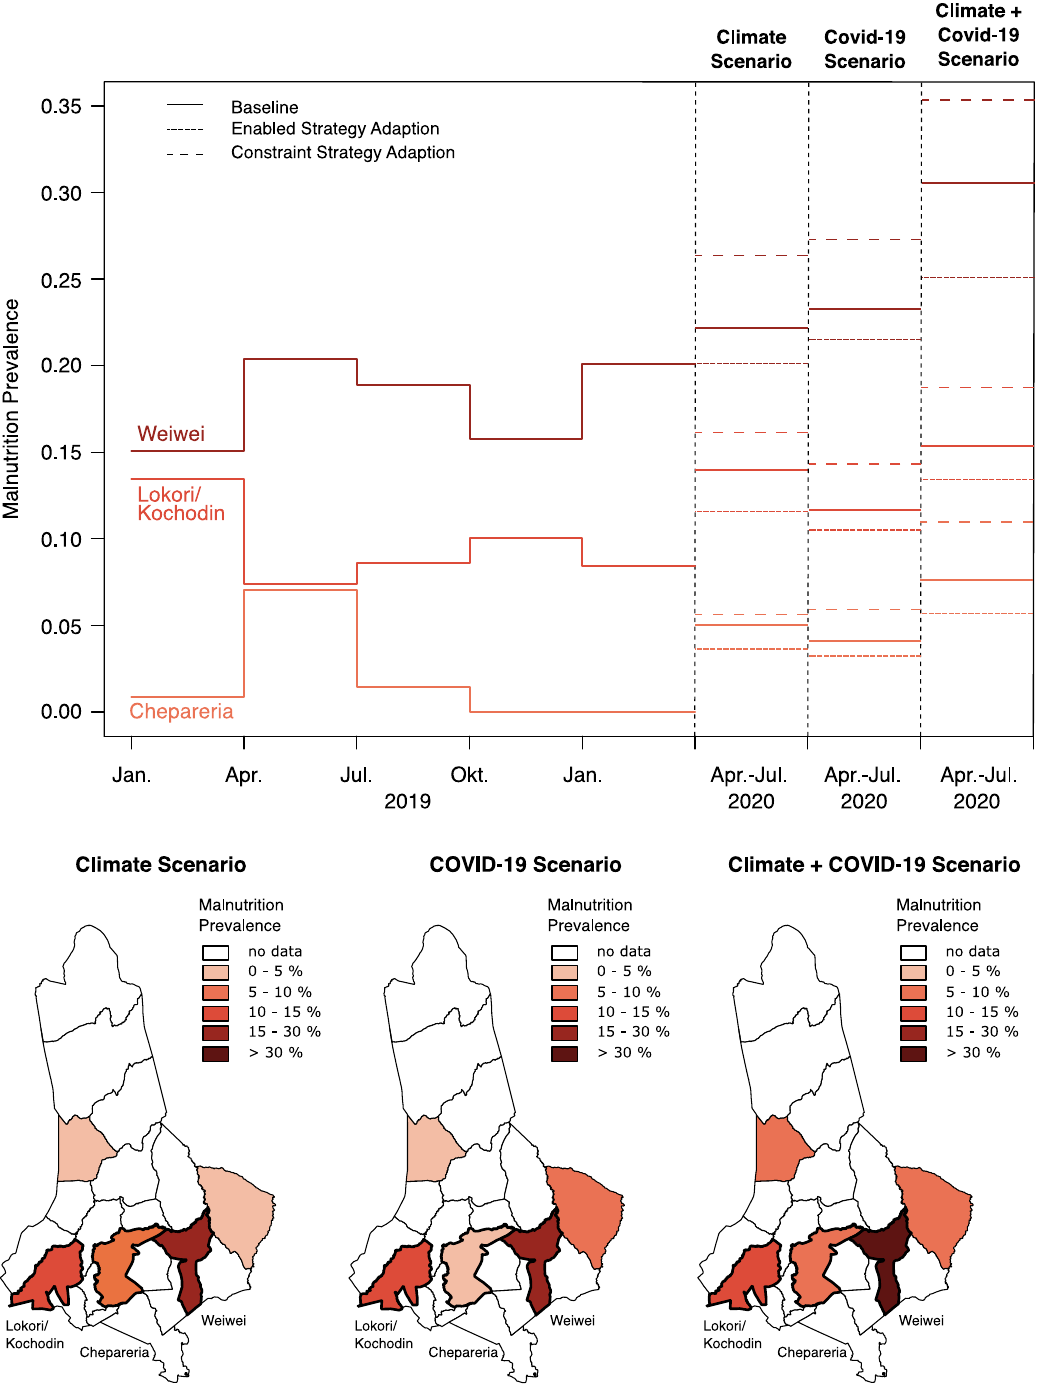
Fig. 7 Counterfactual scenarios for select wards in West Pokot (2020). The top panel depicts simulated malnutrition prevalence for climate, Covid-19, climate & Covid-19 shocks from Apr.-Jul. by ward. The bottom panel maps simulated malnutrition prevalence as a result of shocks for the same set of wards. In both panels, prevalence is measured using the MUAC